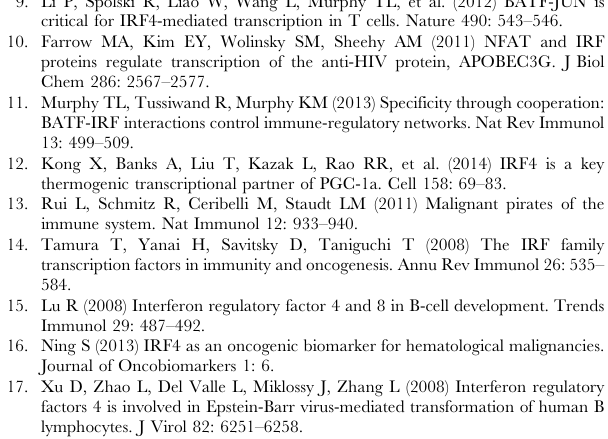
Table S3 Microarray analysis for IRF4 transcriptome in EBV latently infected B